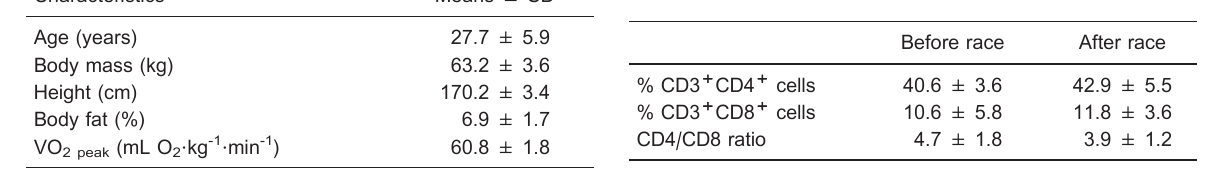
Table 3. Adventure sprint race had no effect on the percentage of T helper (CD3 + CD4 + ) and T cytolytic (CD3 + CD8 + ) lympho- cytes and CD4/CD8